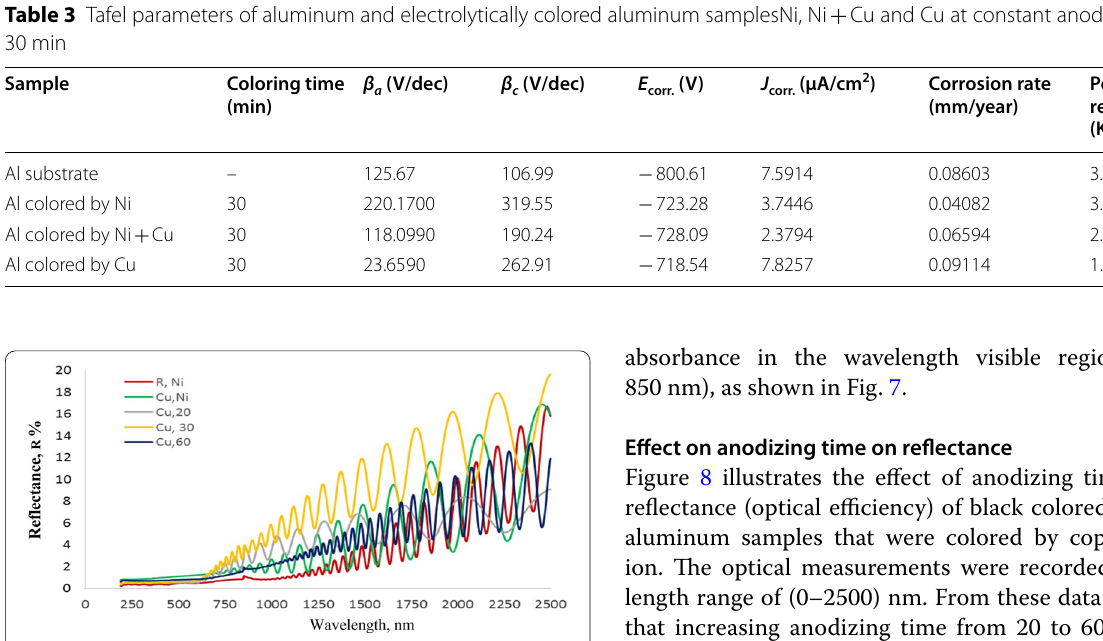
Table 3 Tafel parameters of aluminum and electrolytically colored aluminum samplesNi, Ni